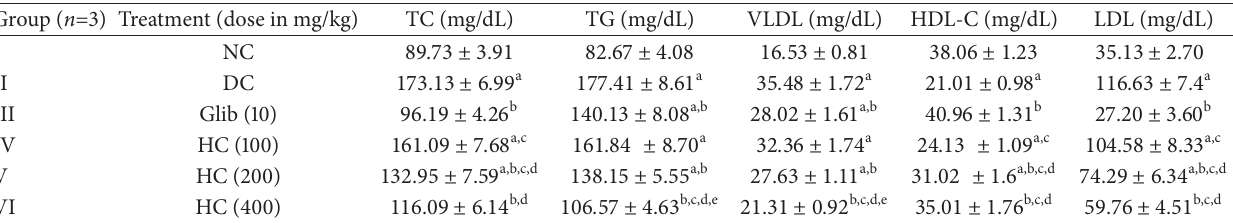
Table 2: Effect of HC on lipid profile of streptozotocin-induced diabetic rats on the 21st day.